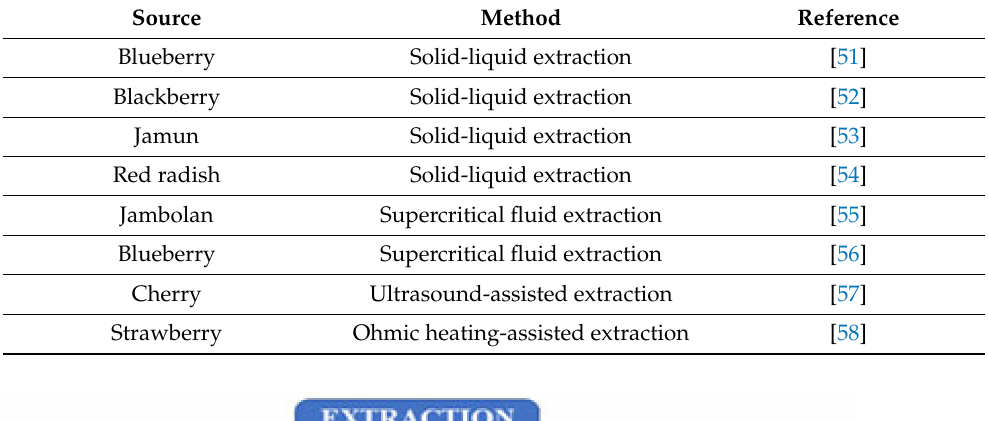
Table 1. Most common extraction methods for the recovery of anthocyanins from natural sources.